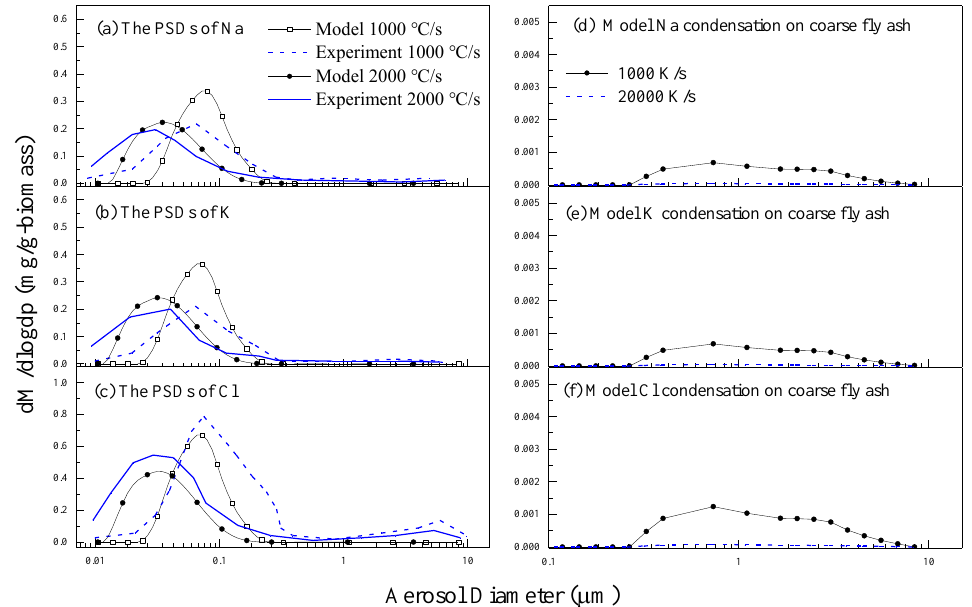
Figure 4. When the cooling rate is 1000 and 2000 °C/s, the calculated mass PSDs of inorganic elements in PM 10 are compared with the measurements and the calculated condensation amount of the elements on coarse fly ash particles at the biomass feeding rate of 0.05 g/min, where ( a – c ) are PSDs of PM 10 . ( d – f ) Condensation of elements on fly ash particles.